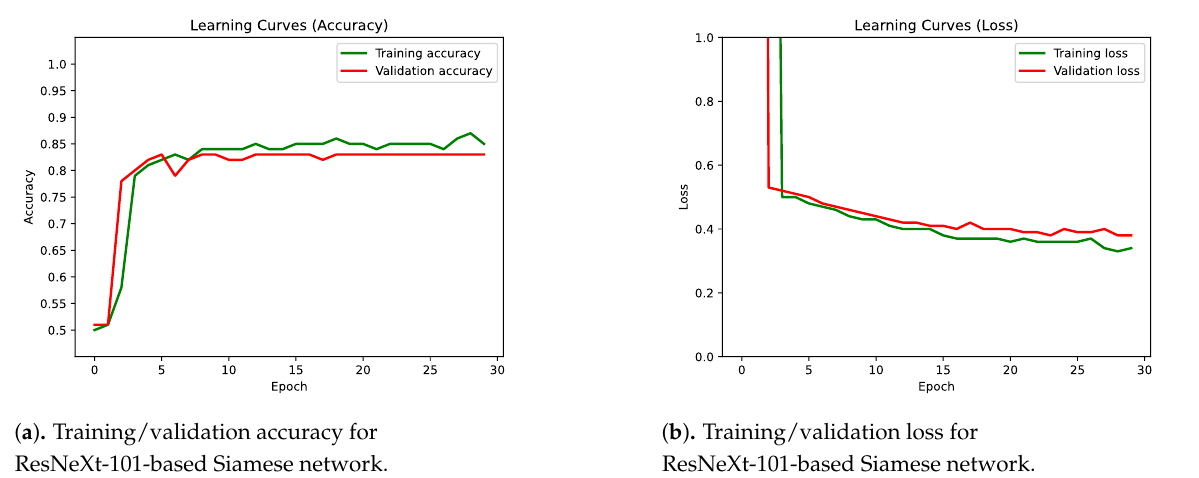
Figure 12. Siamese network training with ResNeXt-101.